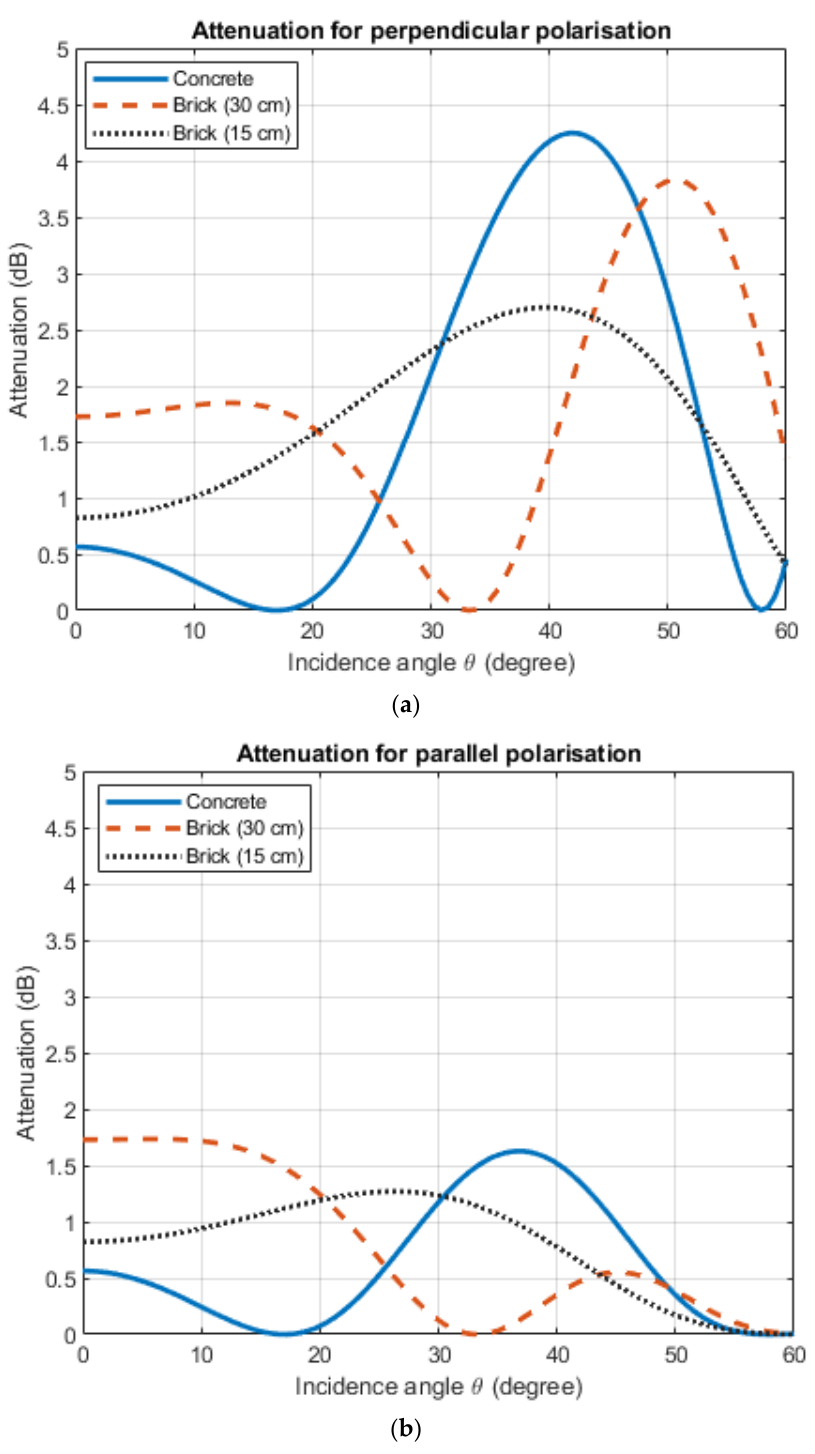
Figure 4. Transmission losses, in dB: ( a ) for perpendicular polarized electric field; ( b ) for parallel polarized electric field.